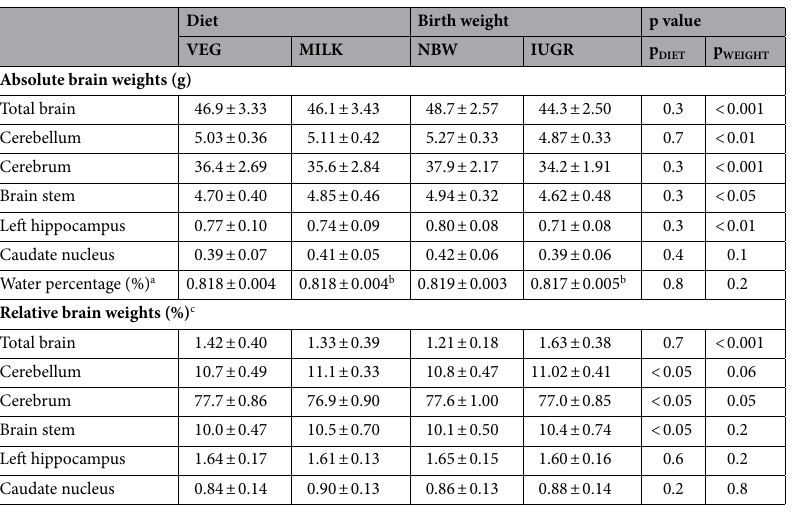
Table 3. Absolute and relative regional brain weights. Data are pooled and presented as main effects of diet and birth weight (n = 18). Data are shown as mean ± SD. All data were analysed using a linear mixed model except water percentage which was analysed by a Mann–Whitney test. p < 0.05 is considered statistically significant. VEG vegetable oil, MILK bovine milk fat, NBW normal birth weight, IUGR intrauterine growth restricted. a Water percentage = left cerebral hemisphere weight before and after dehydration for 2 weeks at 50 °C. b One piglet was removed due to a measurement error (n = 17). c Regional brain weights as a percentage of total brain weight or total brain weight as a percentage of body